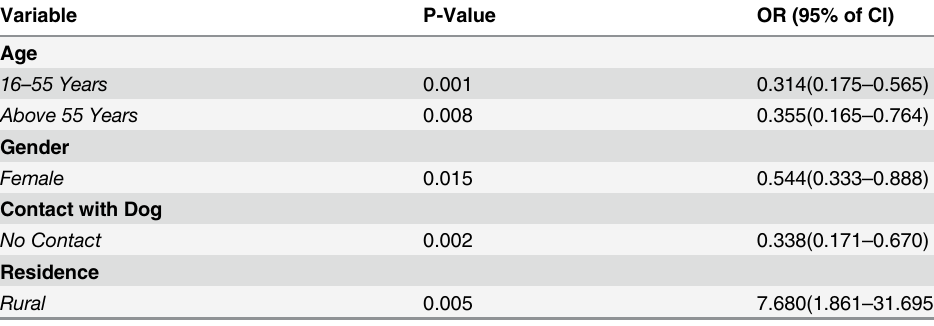
Table 3. Binary logistic regression (Multivariate) analysis of the relationship of exposure variables and seroprevalence of hydatid infection, among the studied population of Kashmir Valley.